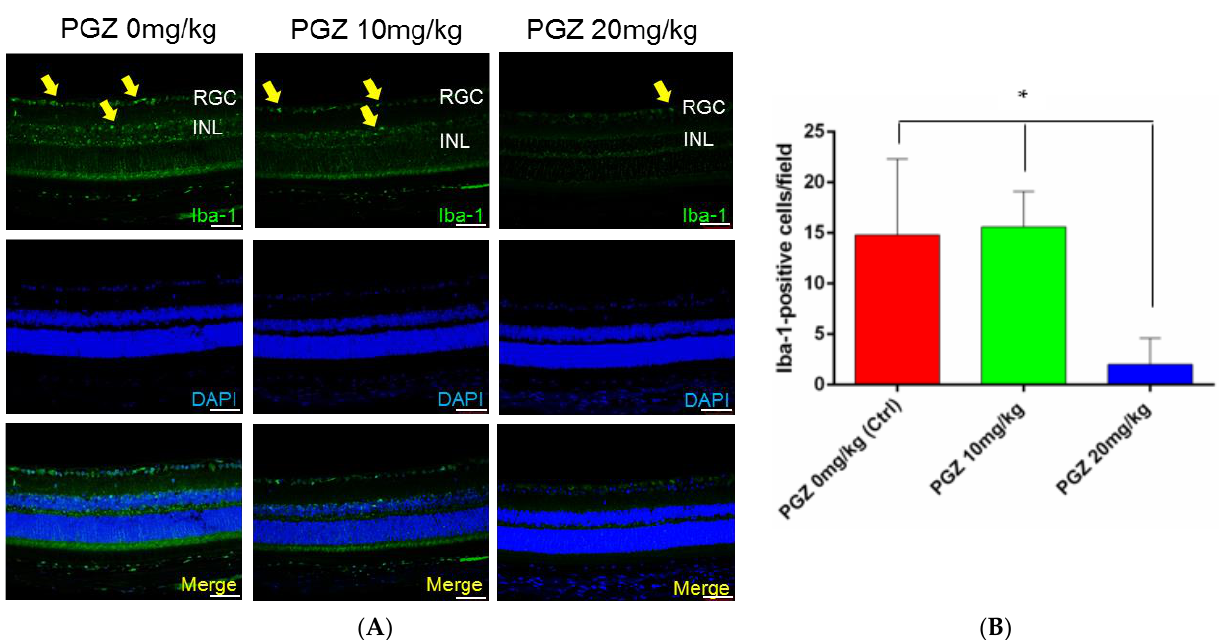
Figure 4. Recruitment of Iba1 + -activated microglia to retina 1 week after AION inducement. ( A ) Microglial cells (yellow arrows) were activated in the retina of DM mice 1 week after AION inducement. ( B ) Bar graph shows less microglial cell infiltration in the retina of DM mice treated with 20 mg/kg PGZ compared with that in the other 2 groups (* p < 0.05) (scale bar: 75 μm; magnification: 200×).